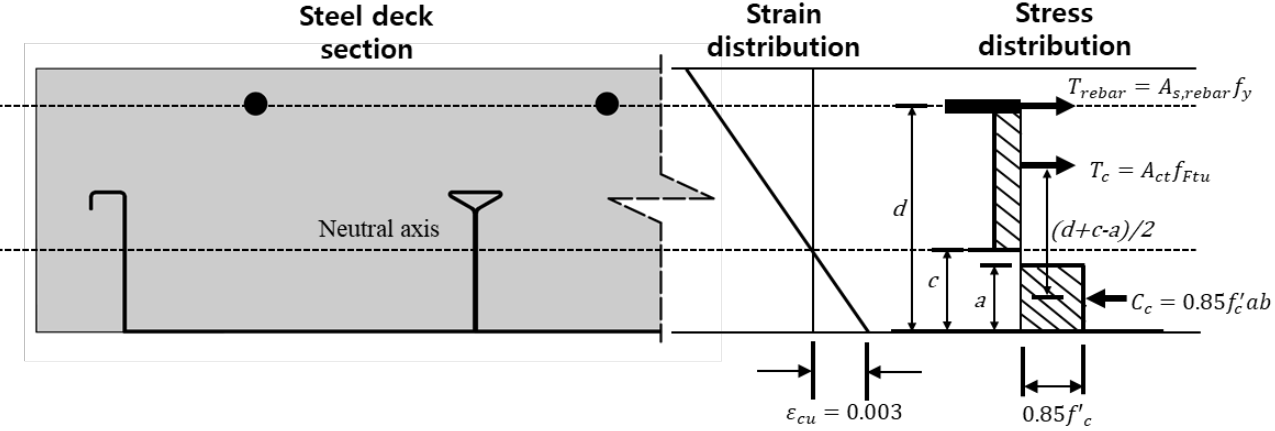
Figure 14. Strain and stress distributions (negative moment).